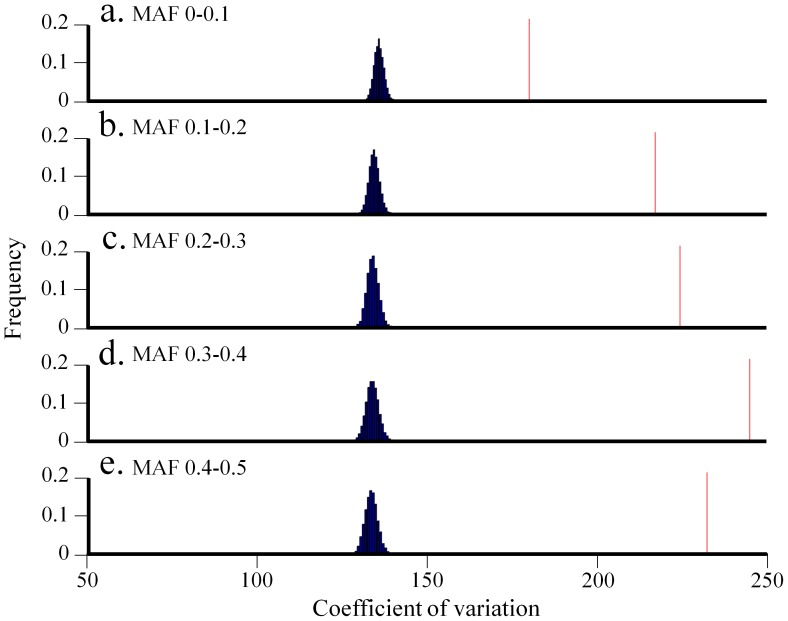
Comparing the coefficient of variation for high- and low-F
ST SNPs.Frequency distribution of coefficient of variation calculated between adjacent F
ST>threshold SNPs (line) and between random samples of F
ST<threshold SNPs (histogram) for five allele frequency groups (a–e).